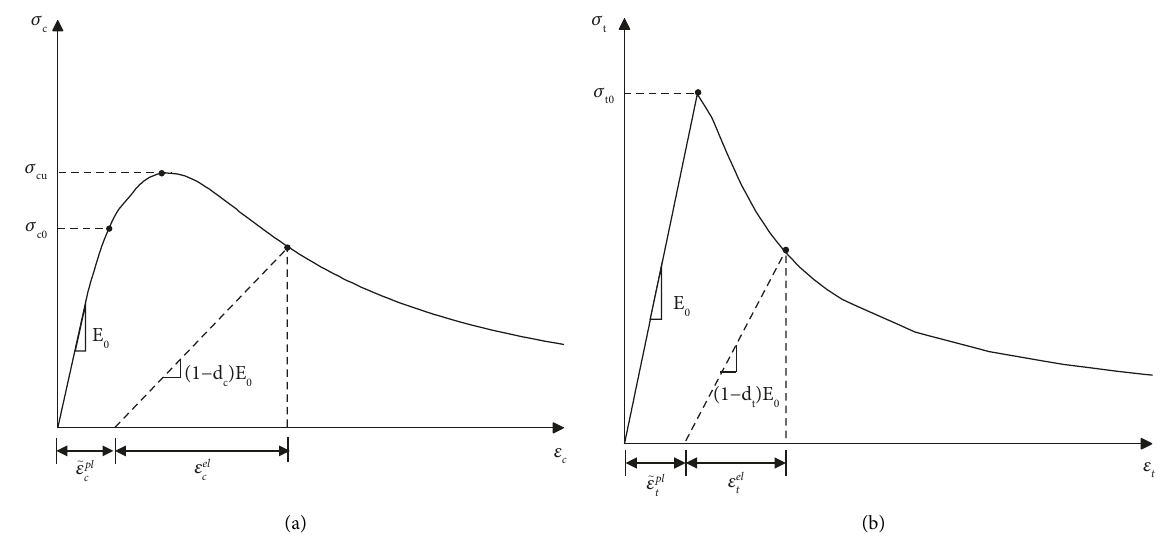
Figure 1: Response curves of concrete to uniaxial load in tensile (a) and compression